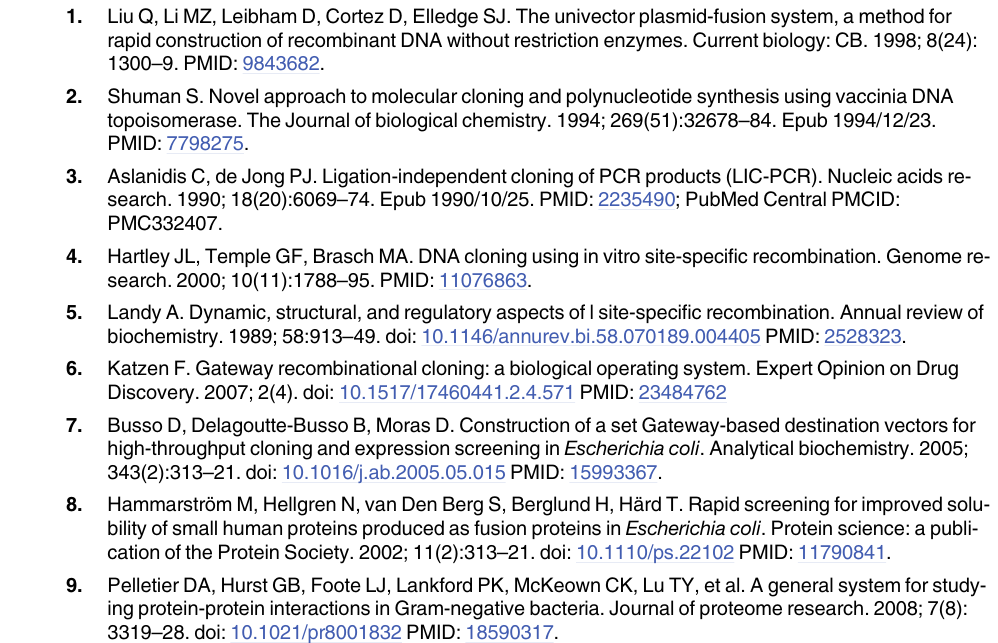
S1 Table. Oligonucleotides used in this study. S2 Table. Plasmids used in this study. S3 Table. Efficiencies of LR